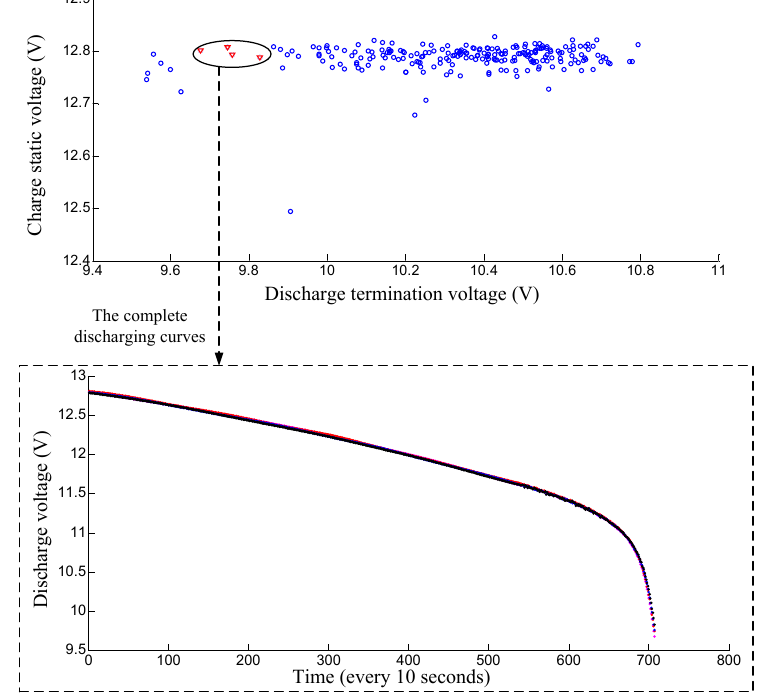
Figure 7. The first successful-grouping battery pack of our method using the complete discharge curves. Note that the discharge curves of this battery pack are very close to each